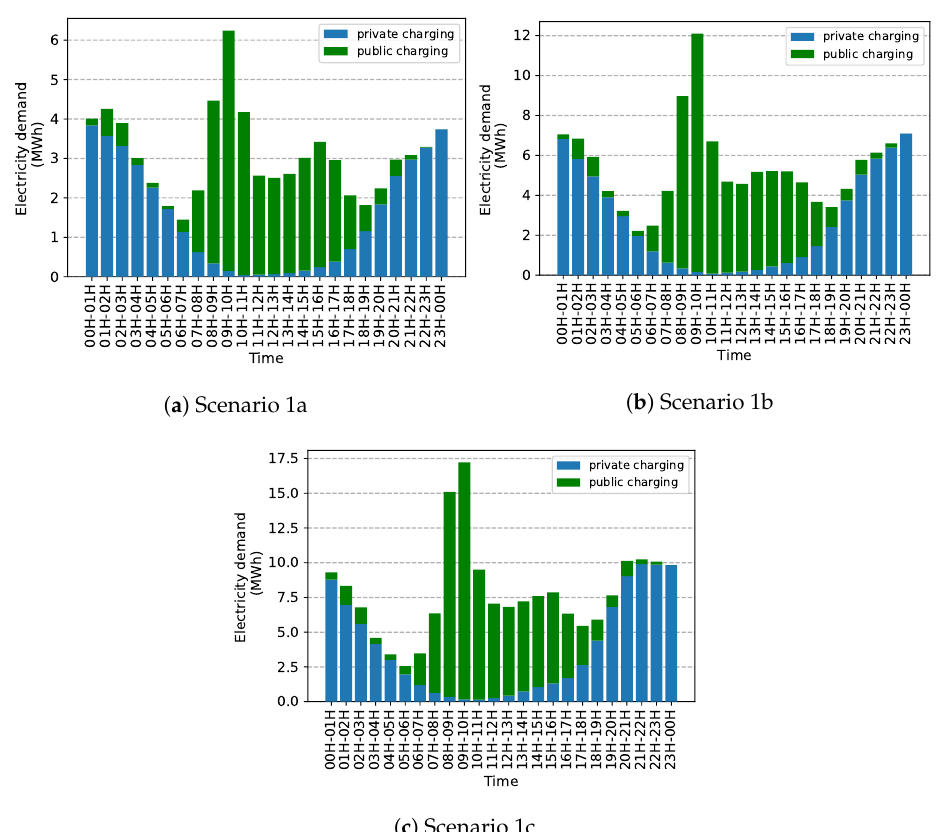
Figure 9. Aggregated hourly load profile due to EV charging for different scenarios at 2035 in the city of